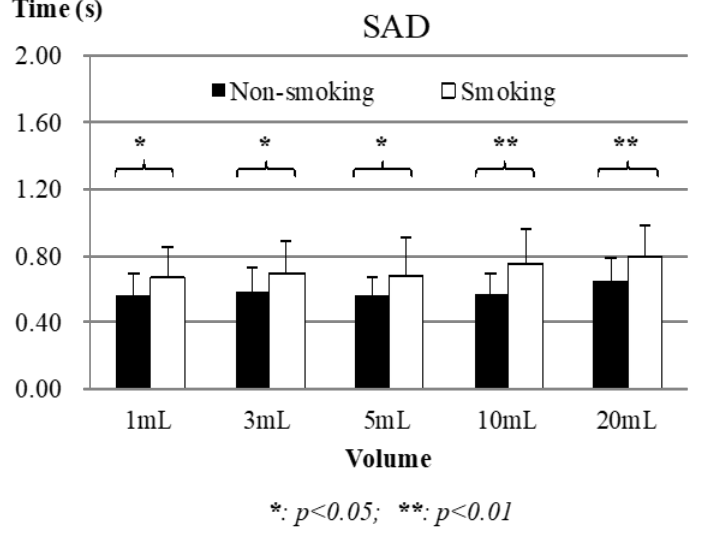
Figure 8. Apnea time (SAD) comparison results between nonsmoking and smoking groups. Piecemeal swallowing cases were excluded.